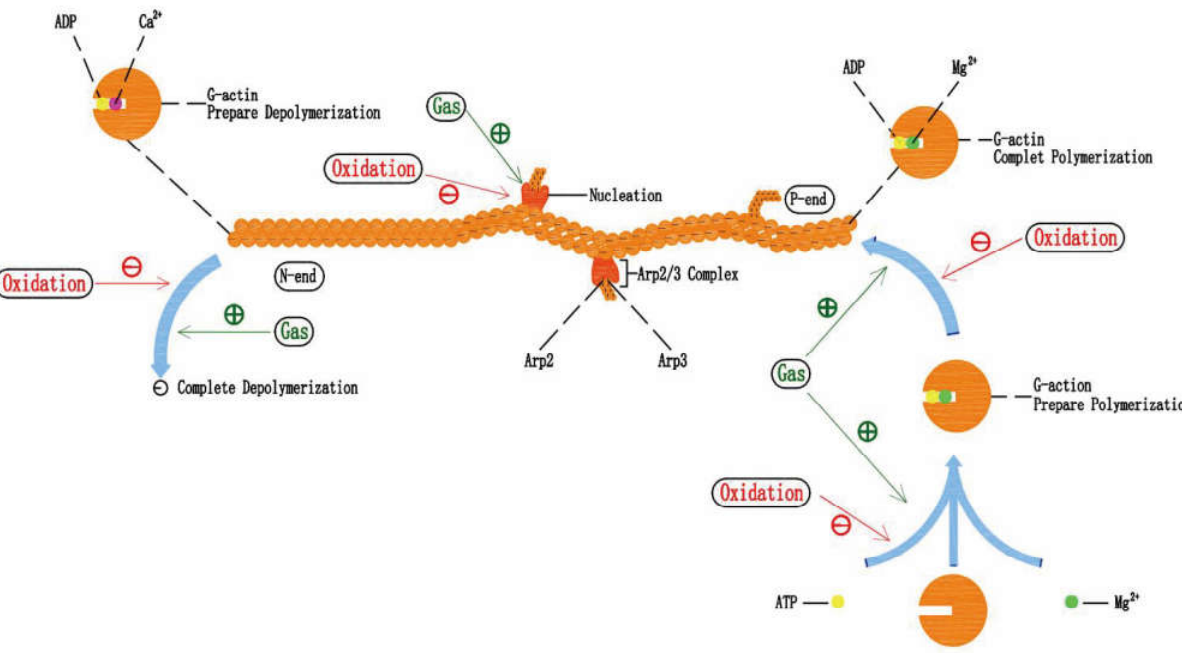
Figure 3. The potential mechanisms of gastrodin protecting actin filament polymerization under oxidative stress. Gastrodin protects the mitochondria to produce ATP, increasing the amount of ATP-bound G-actin, and reduces G-actin oxidation, thus improving the actin filament polymerization rate and reducing the depolymerization rate. At the same time, gastrodin also protects the Arp2/3 complex-induced nucleation process.